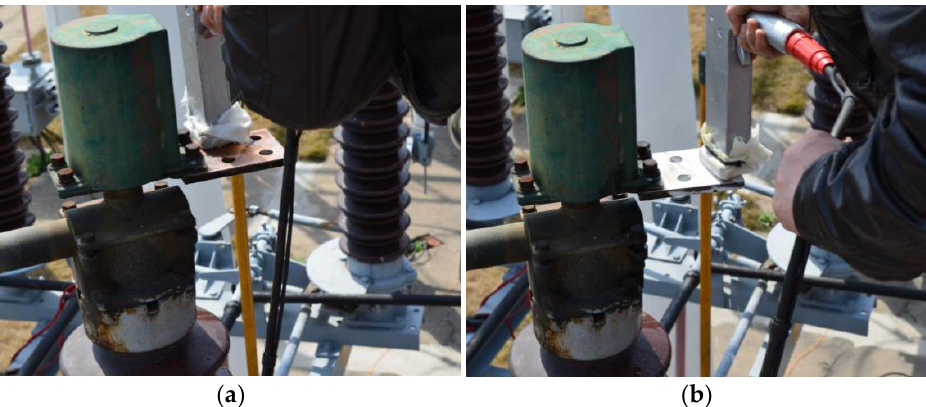
Figure 9. On-site brush plating processing diagram for large instrument parts. ( a ) brush plating before , ( b ) brush plating after.